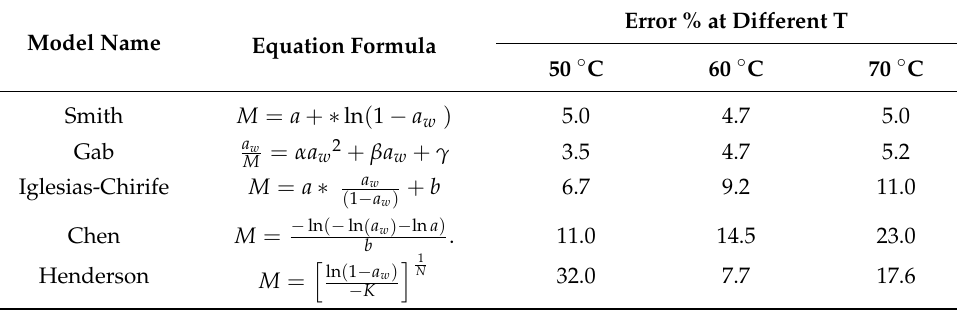
Table 2. Models applied to interpolate data with errors at different